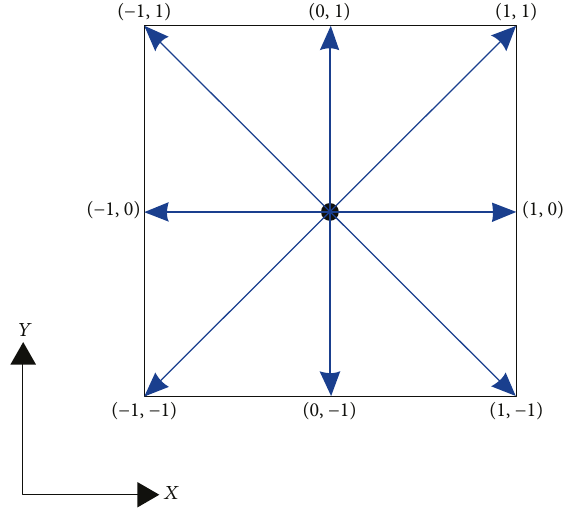
Figure 1: The two-dimensional 9-velocity lattice